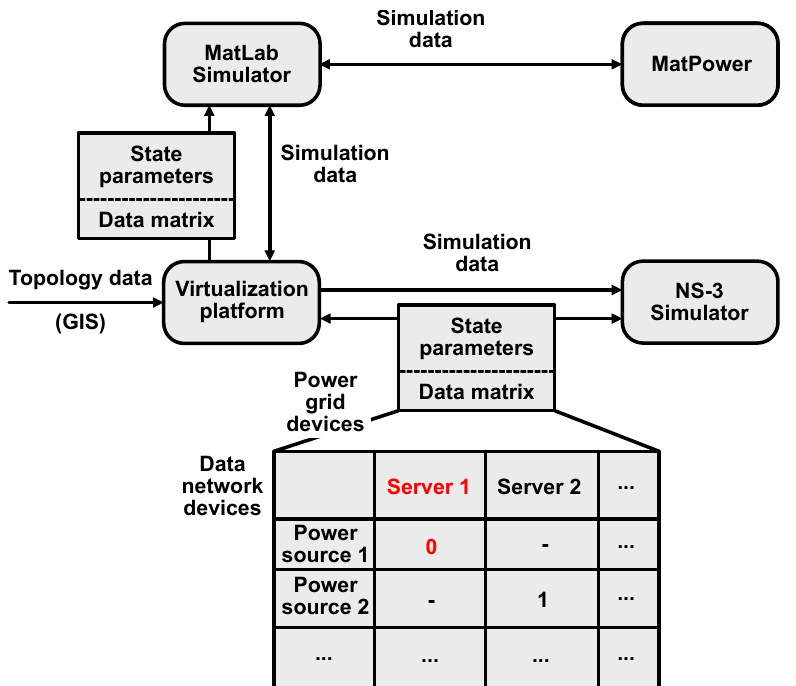
Figure 3. Simulation software interconnection